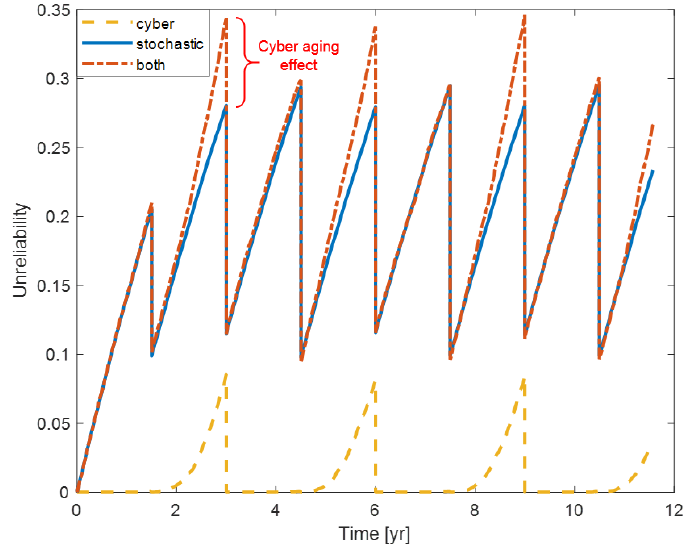
Figure 10. Result of system unreliability under a normal